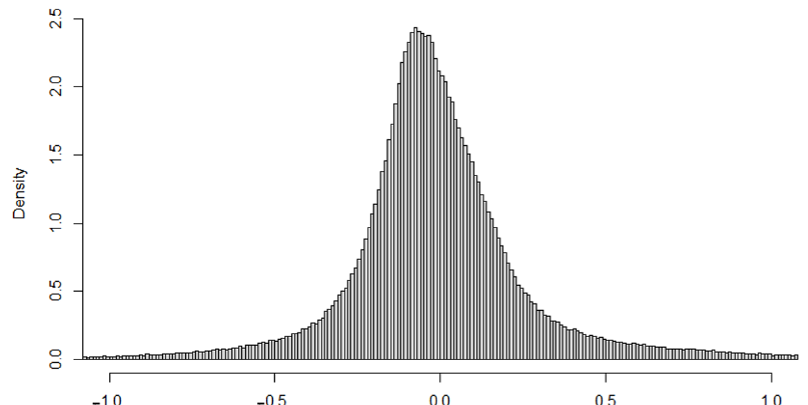
Figure 5. Trimmed histogram of the discrepancies model (error model) of the Allo zone